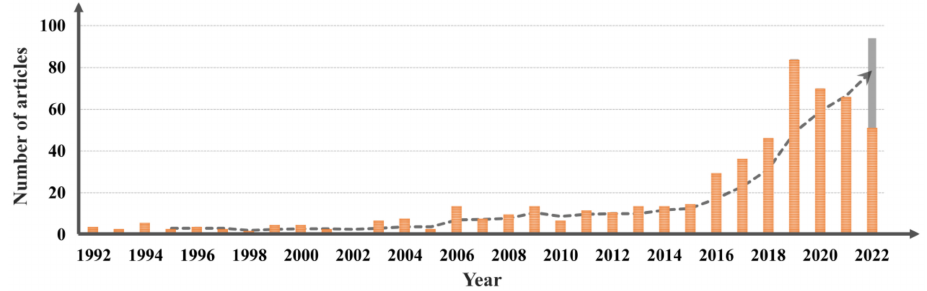
Figure 1. Statistical chart of related literature in 1992–2022.